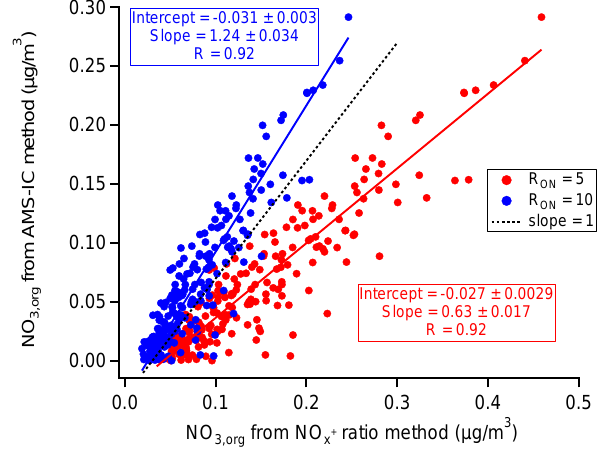
Figure 11. Comparison of estimated concentration of “nitrate func- tionality from organic nitrates” (i.e., NO 3 , org ) at the Centreville (CTR) site between the AMS-IC method and NO + x ratio method with R ON values of 5 and 10. The intercept and slope are obtained by orthogonal fit, which considers measurement errors in both de- pendent and independent variables. The correlation coefficient R is obtained by linear least-squares fit. Intercepts are within the detec- tion limit of PILS-IC nitrate (i.e., 0.03µgm − 3 ). The 1 : 1 line is off- set by the detection limit of PILS-IC nitrate (i.e., − 0 . 03µgm − 3 ) for visual clarity. The uncertainty of PILS-IC measurements is about 10% according to Weber et al. (2001).